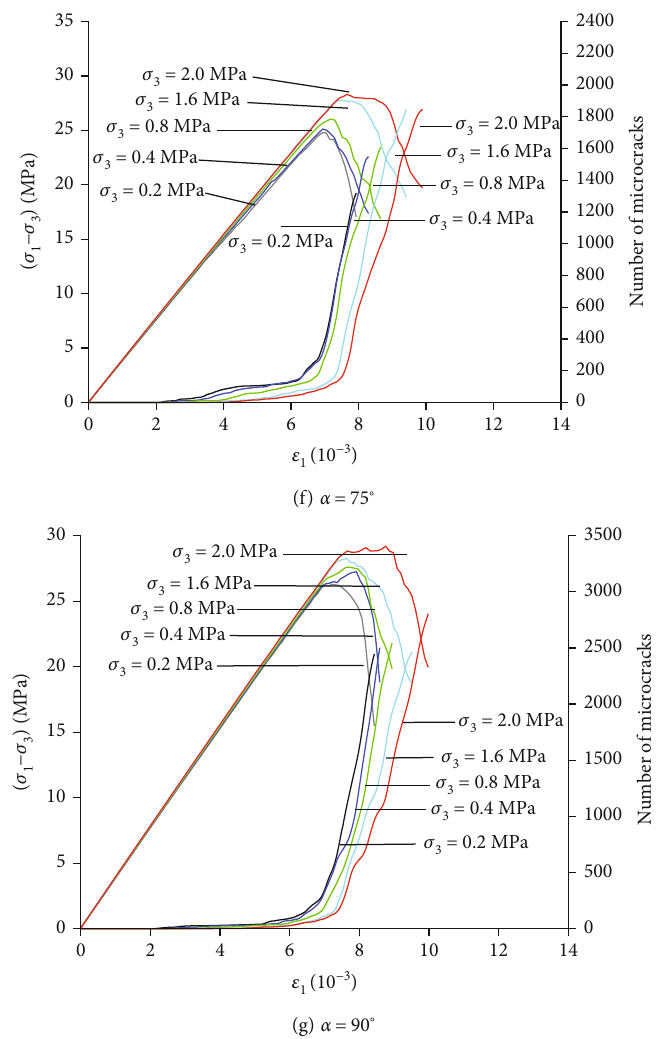
Figure 5: Stress and microcracks number versus axial strain curves under di ff erent con fi ning